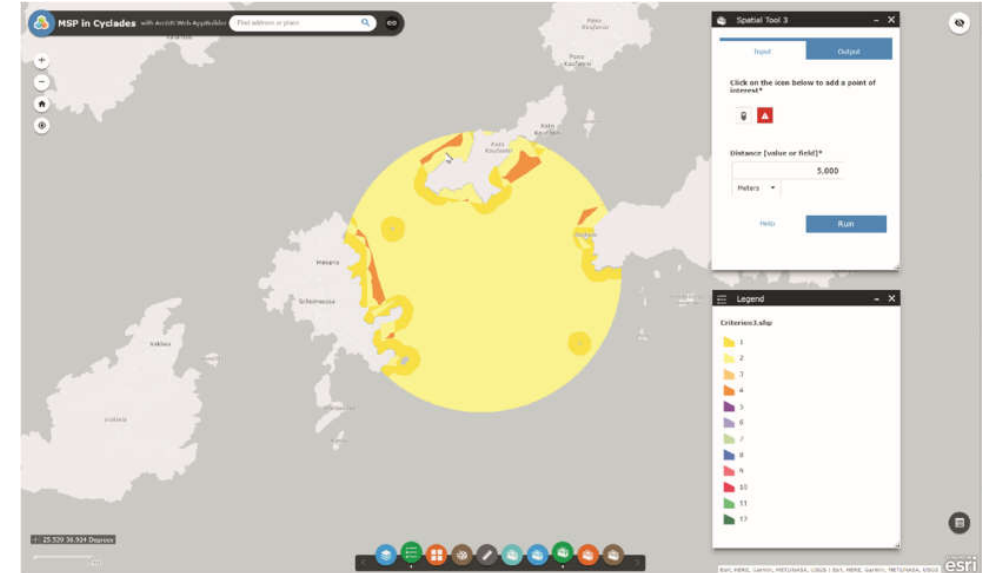
Figure 5. Areas of conflicts within a user-defined area.